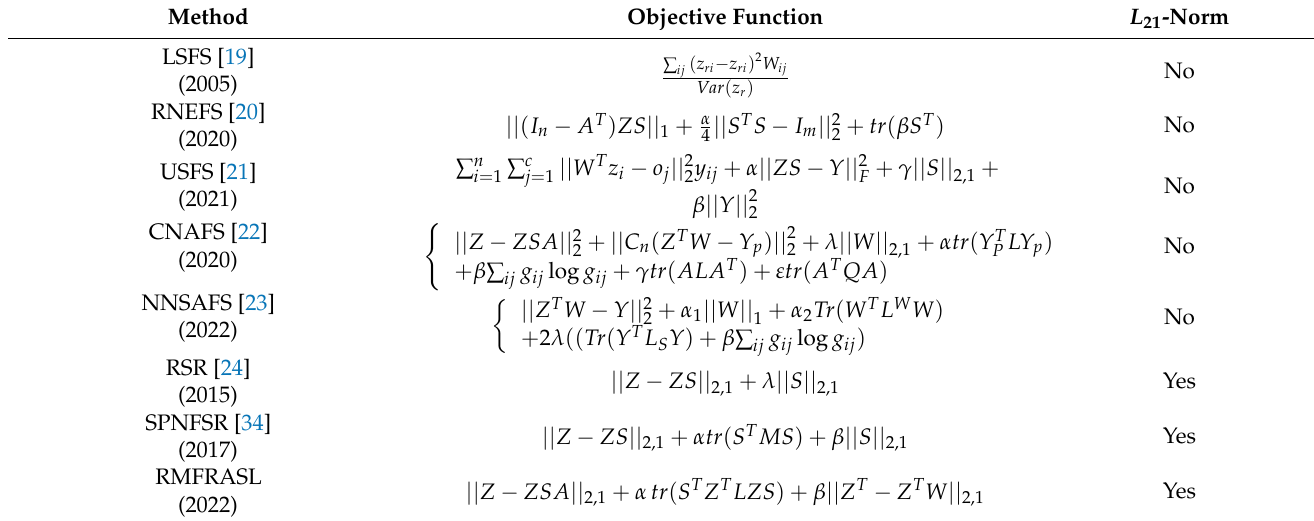
Table 4. The summarization of compared methods in this